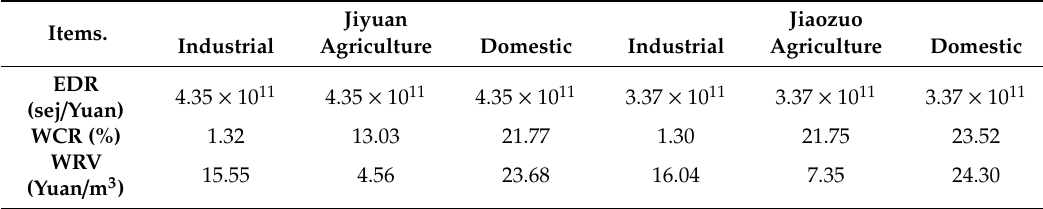
Table 5. Emergy / currency ratio (EDR), water contribution rate (WCR) and water resource values (WRV) of each industry.